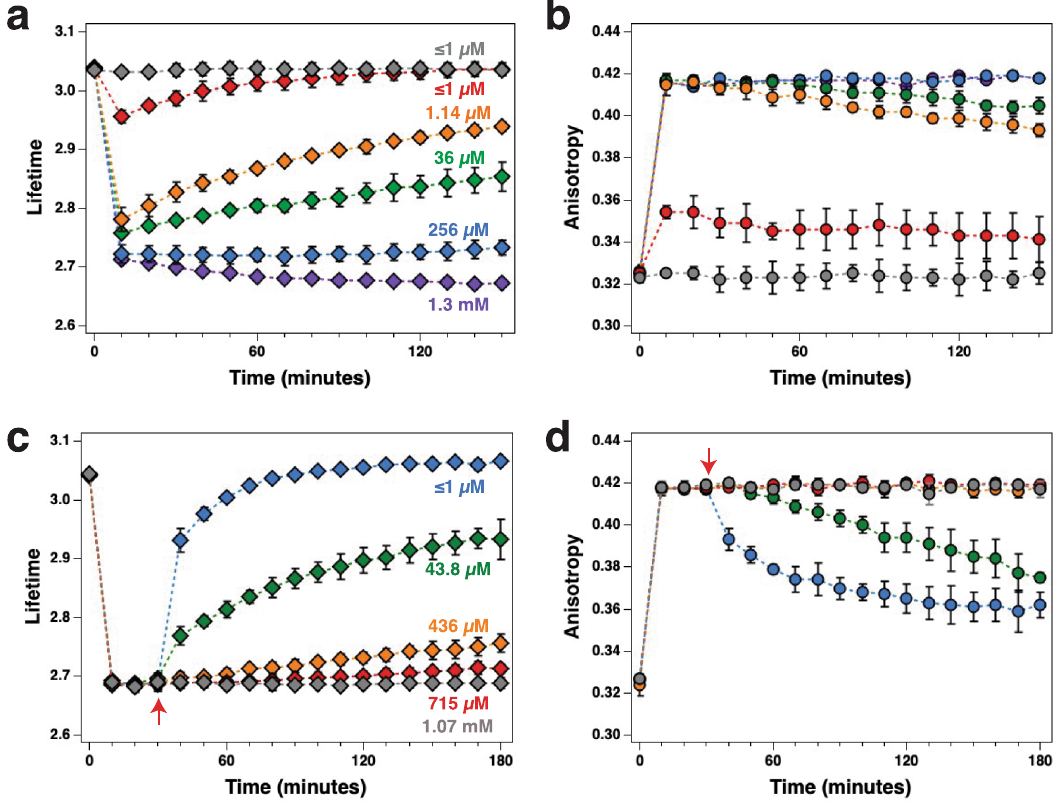
Fig.6|mCherry-NR2BassociationanddisassociationfrommVenus-CaMKII α as afunctionofcalciumconcentration. InvitroVenuslifetime( a )andanisotropy( b ) was measured when 0.2 (gray), 0.5 (red), 0.7 (orange), 1.0 (green), 1.5 (blue), and 3.0mM (purple) CaCl 2 was added to our reaction to activate CaMKII. Representa- tive anisotropy and lifetime decay traces depicting the calcium dependence of activation are shown in Supplementary Fig. 5. Following activation of mVenus- CaMKII α and mCherry-NR2B binding in response to 1.07mM free calcium, the calcium chelator EGTA was added to test if NR2B binding was reversible. Venus